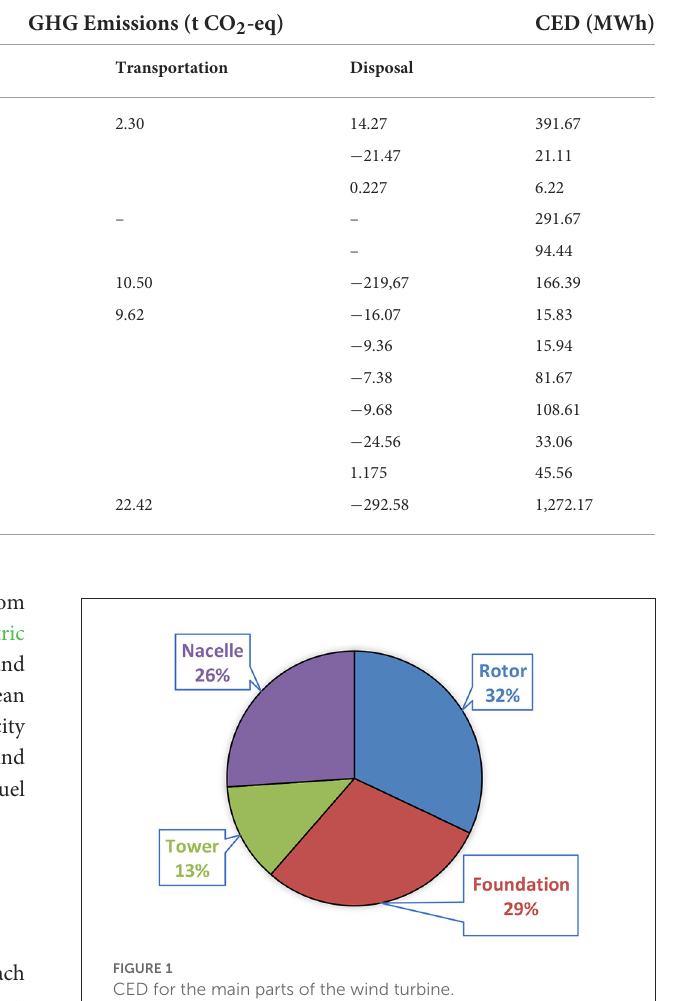
TABLE 2 GHG emissions per component and energy consumed in each phase.